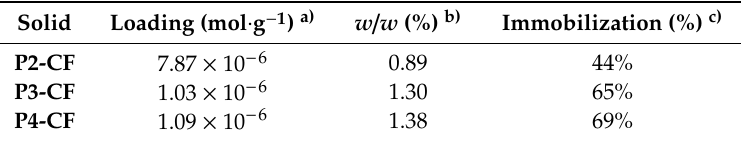
Table 2. Porphyrin immobilization in